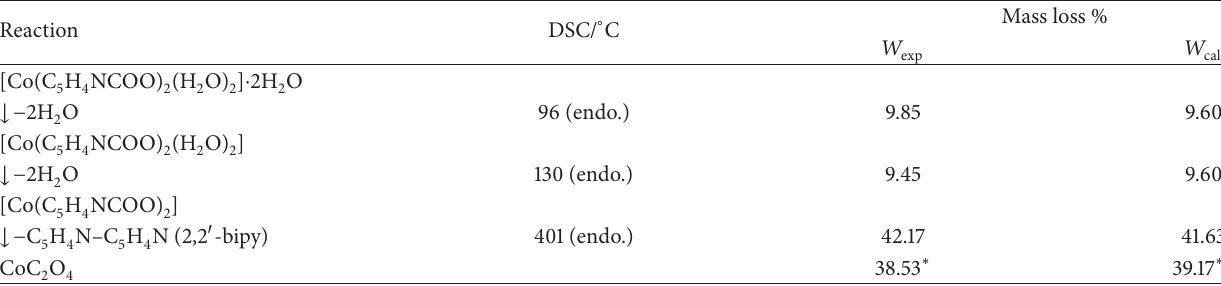
Table 4: Thermal decomposition data of the title complex.